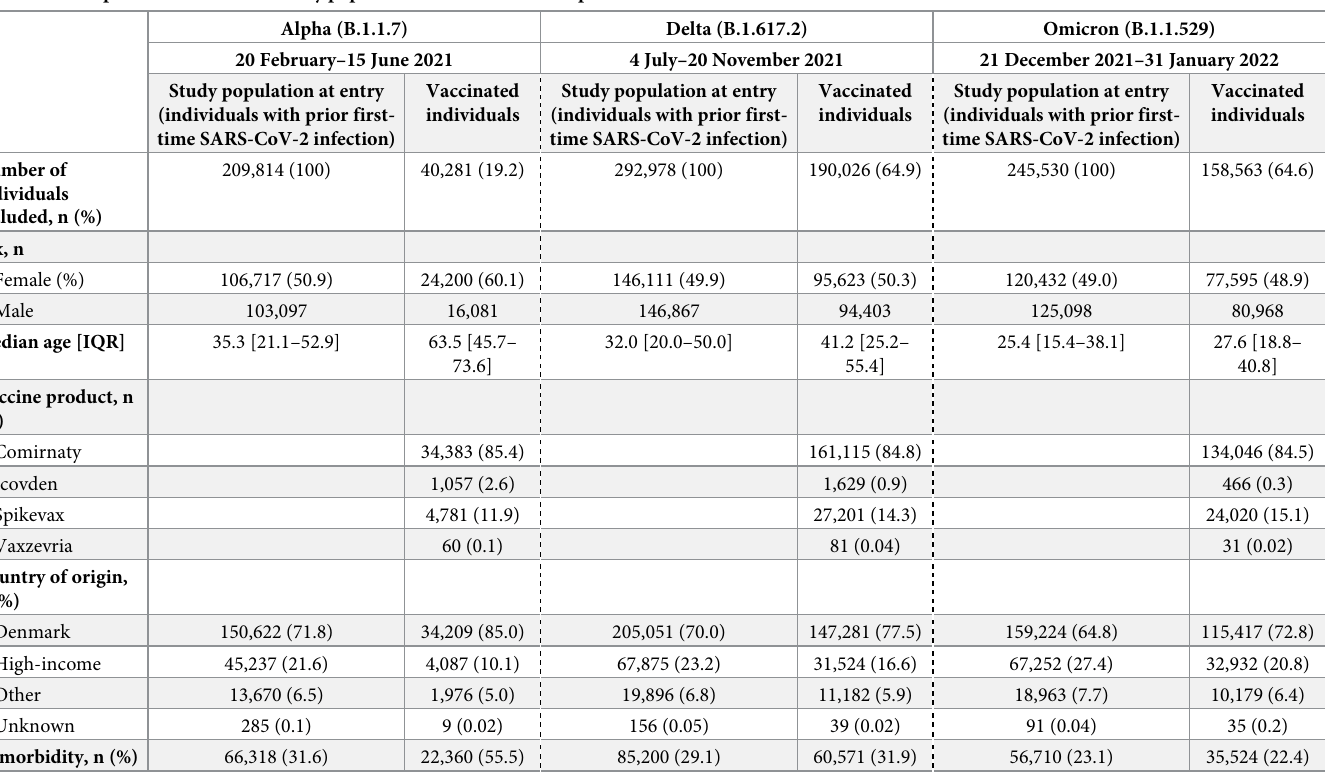
Table 1. Descriptive overview of the study population at start of